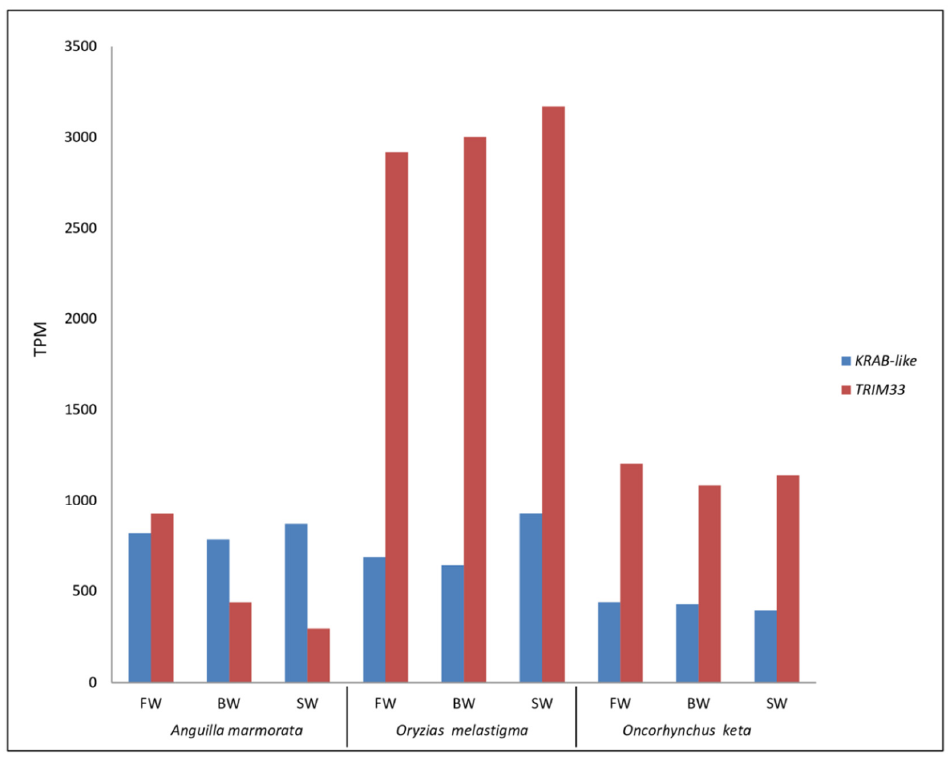
Figure 6. Transcriptional activity of KRAB -like and TRIM33 genes in Anguilla marmorata, Oryzias melastigma, and Oncorhynchus keta gill transcriptomes. FW: freshwater; BW: brackish water; SW: salt water.